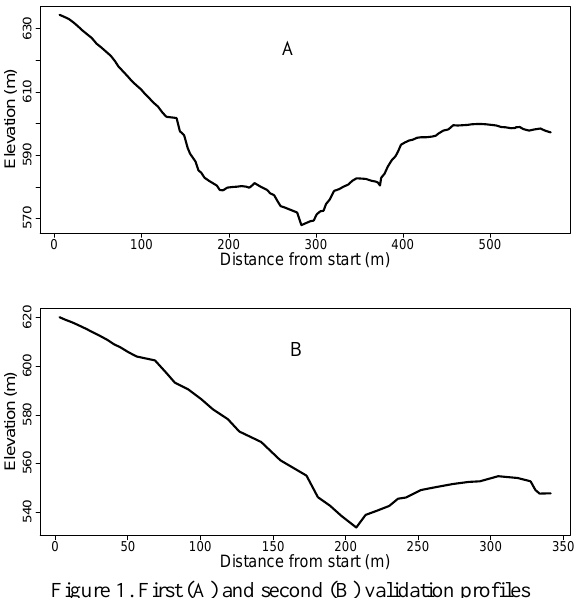
Figure 1. First (A) and second (B) validation profiles Finally, the river was digitized by photointerpretation on a scale of 1:3000 using two IKONOS orthorectified panchromatic images dating from 2005 with a resolution of 0.8